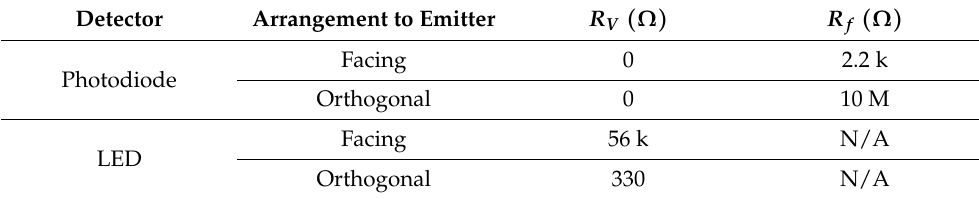
Table 1. Implementation resistor values for each implementation and arrangement